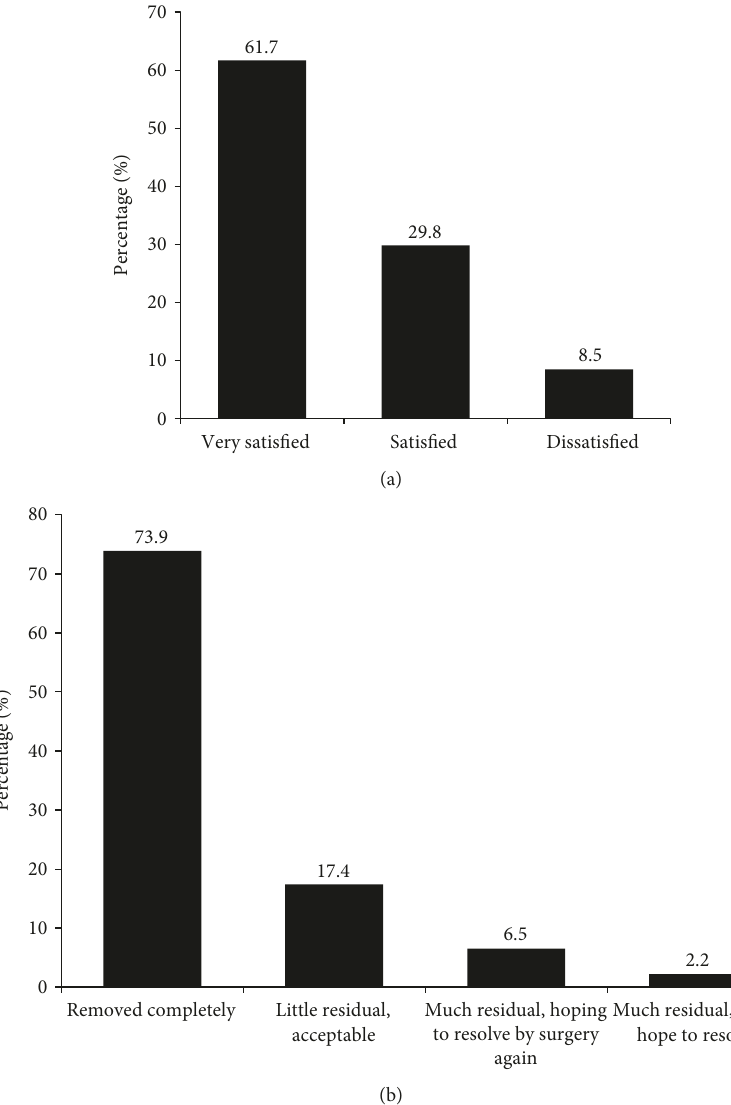
Figure 2: (a) Patients ’ satisfaction on the vitrectomy surgery ( n = 47 ). (b) Patients ’ subjective feeling on the fl oaters 1 week after the vitrectomy surgery ( n = 46 , one patient who developed endophthalmitis was unavailable for this